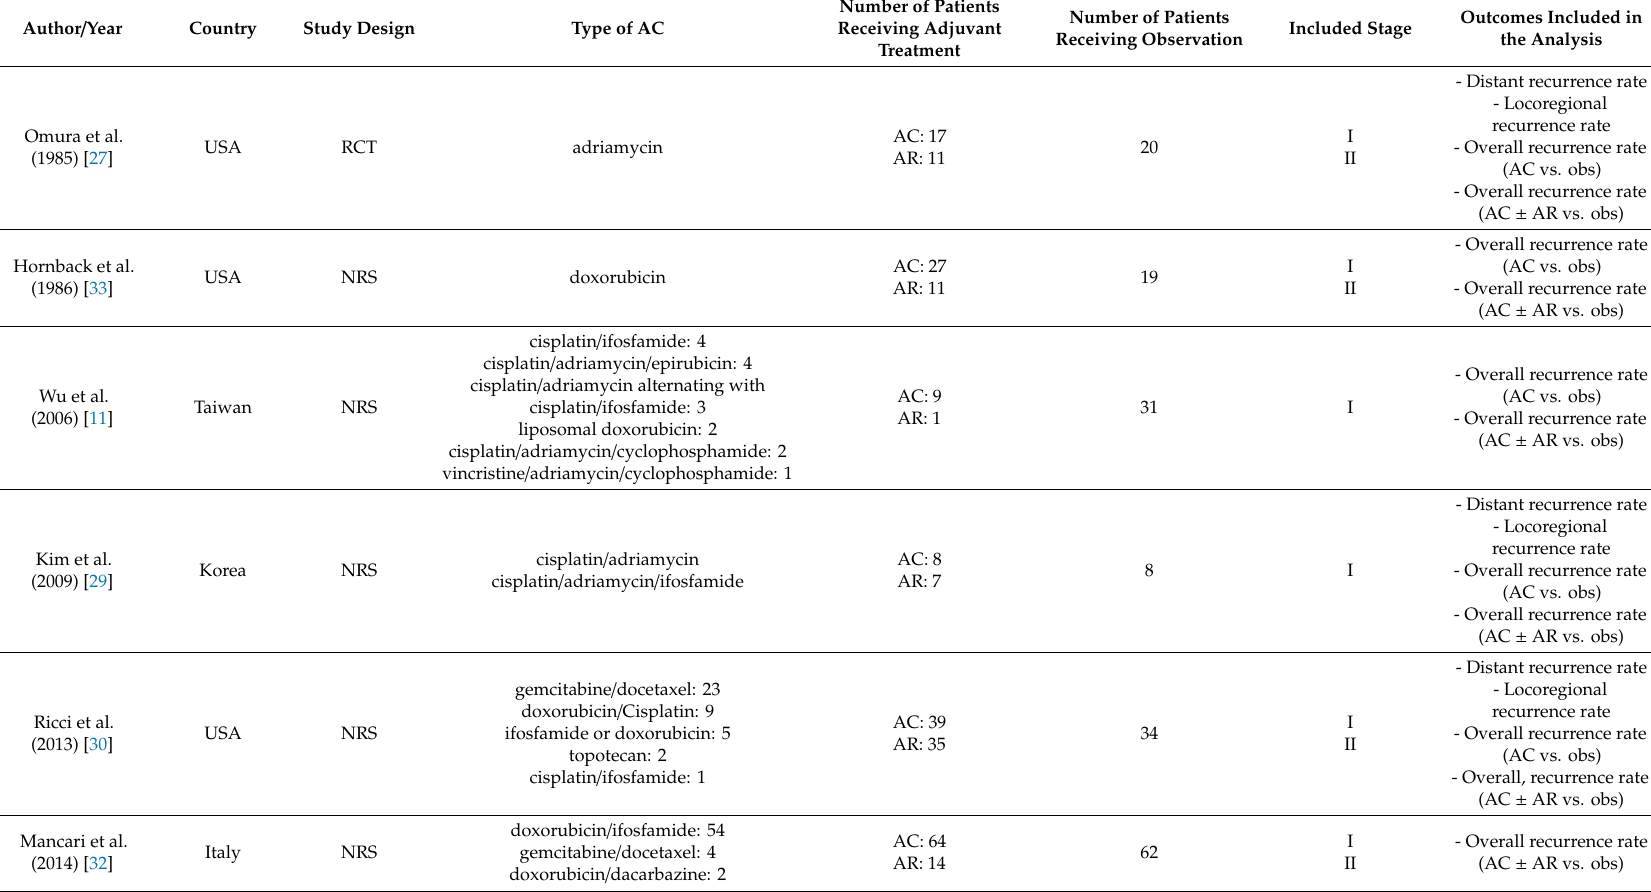
Table 2. Summary of the included